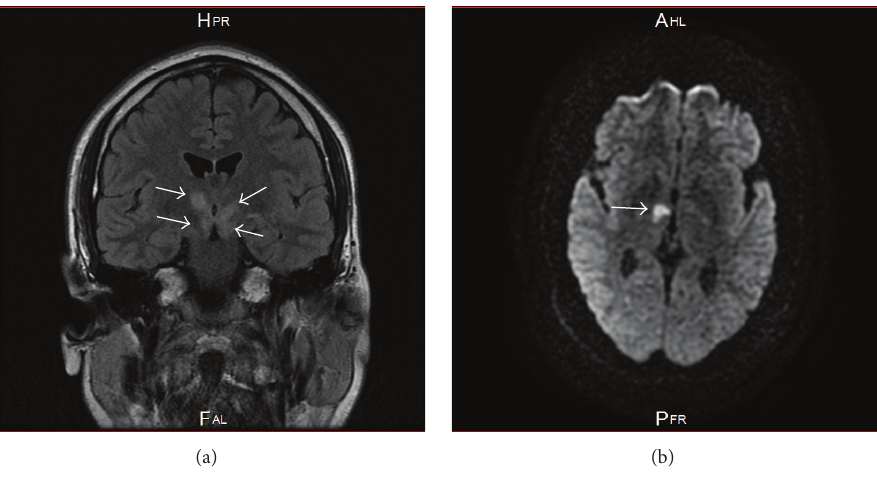
Figure 1: Images of the brain MRI study. (a) Coronal FLAIR-T2 showing bilateral pathological hyperintense signal abnormalities in periventricular, periaqueductal area, in both crura cerebri, and in both hypothalami (arrows). (b) Axial diffusion weighted imaging DWI showing a right thalamic infarct as a hyperintense